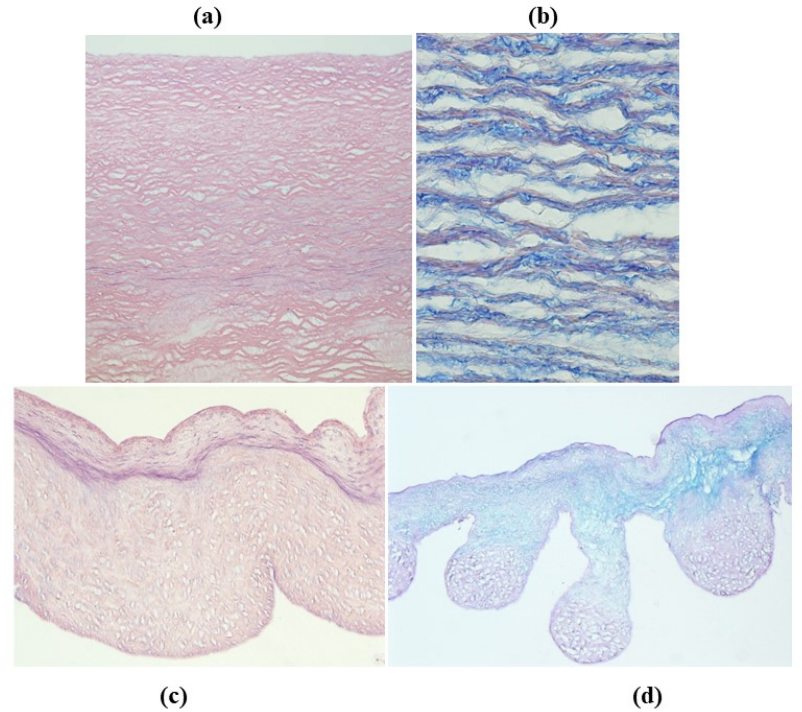
Figure 31. Decellularization of unimplanted aortic homograft: wall ( a , b ) and cusps ( c , d ). Elastic fibers and ground substance of extracellular matrix are preserved (hematoxylin-eosin, Heidenhein and Alcian PAS stain). From [67], with permission.